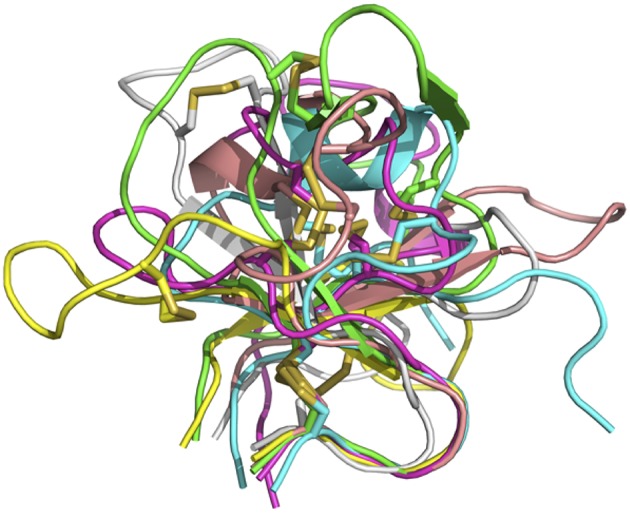
Overlay of six bovine knob structures. The knob for antibody BOV-1 is colored in green, BOV-2 in magenta, BOV-3 in cyan, BOV-4 in salmon, BOV-5 in yellow, and BOV-6 in gray. Cysteine residues are shown in stick representation.